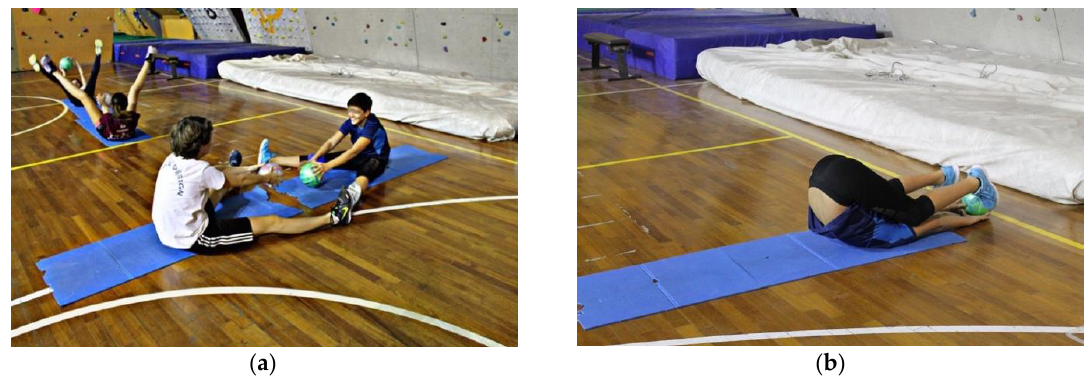
Figure 4. ( a ) Starting position of the mobilization of the spine and coxo–femoral joint exercises. ( b ) Ending position of the mobilization of the spine and coxo-femoral joint exercises.